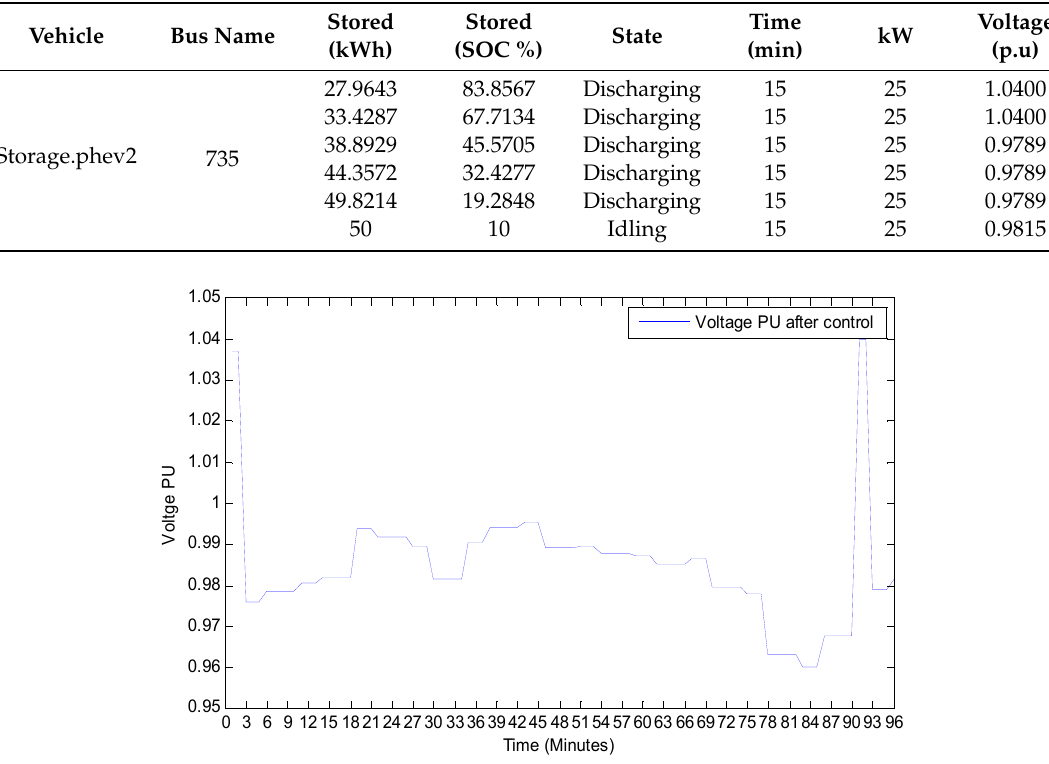
Figure 17. Voltage profile when control algorithm is introduced.